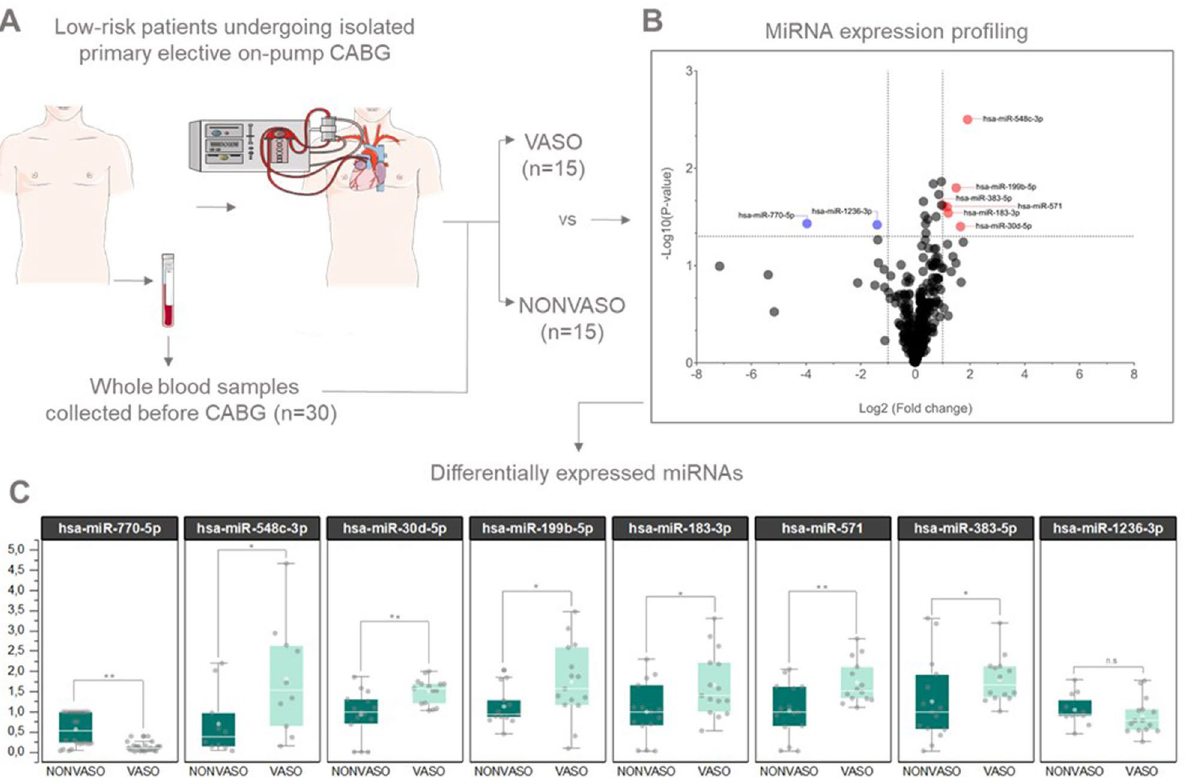
Figure 1. ( A ) Workflow of the study design: A cohort of 30 samples was used for the miRNA profile, divided into patients who developed (VASO group, N = 15) and did not (NONVASO group, N = 15) VS after surgery. ( B ) Volcano plot showing that among the 754 screened miRNAs, eight were differentially expressed in the VASO group compared to NONVASO, from those, six miRNAs were increased (red dots): hsa-miR-548c-3p, hsa-miR- 30d-5p, hsa-miR-199b-5p, hsa-miR-183-3p, hsa-miR-571, hsa-miR-383-5p and two were decreased (blue dots): hsa-miR-1236-3p, hsa-miR-770-5p. ( C ) Mann–Whitney non-parametric test and, for outlier’s detection, the ROUT method (based on the False Discovery Rate—FDR) was used to compare both groups, using the values of ∆Ct after global mean normalization and calculation of the relative expression 2 -∆∆Ct (fold change) for each miRNA. Considering P -value ≤ 0.05 as statistically significant. Figure 1A was partly generated using Servier Medical Art, provided by Servier, licensed under a Creative Commons Attribution 3.0 unported